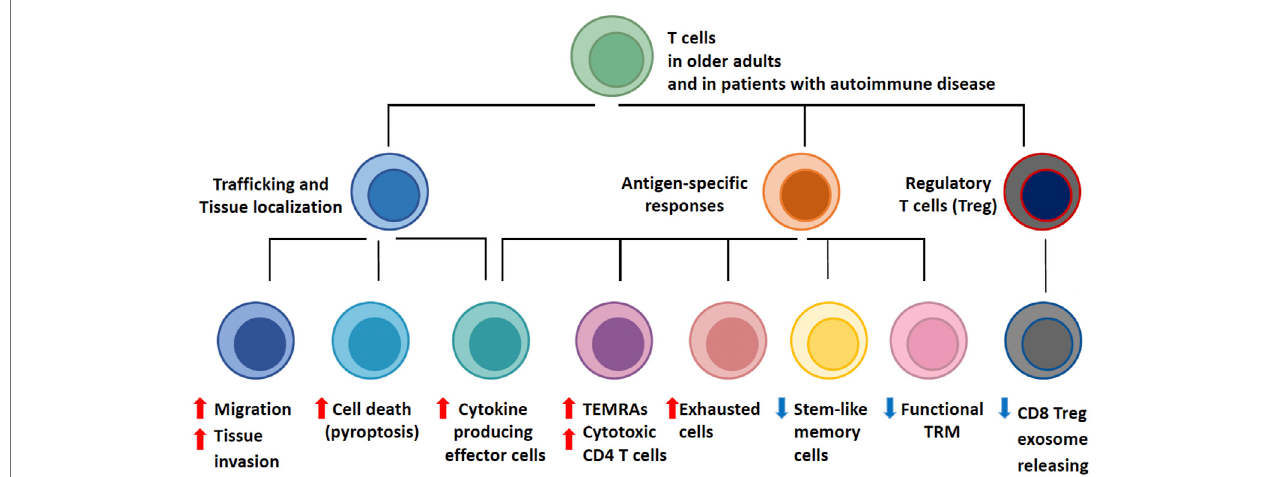
FIGURE 1 | T-cell Aging-Associated Phenotypes (TASP). T cell aging leads to profound changes in the composition of the T cell pool. Major determinants of T cell aging include the dwindling generation of new T cells in face of continuous attrition and the stress imposed by acute and chronic antigen exposure, progressive differentiation and homeostatic proliferation. As naïve T cell populations shrink, the spectrum of phenotypically and functionally de fi ned T cell subsets expands. Functional adaptations occur in three major domains: with age, T cells become more mobile and tissue invasive; with age, T cells differentiate into effector populationsthatarecytokinehyperproducersandpossesscytotoxicfunctions;withage,regulatoryTcells(Treg)deteriorate,allowingforunopposedeffectorresponses. The assembly of T cell phenotypes in the aged T cell pool biases towards less speci fi c and more in fl ammatory immunity. T cell aging-associated phenotypes (TASP) are enrichedinpatientswithlate-onsetautoimmunediseasesandhavebeenimplicatedinpathogenictissuein fl ammation,identifyingtheTcellagingprocessasariskfactor for the loss of